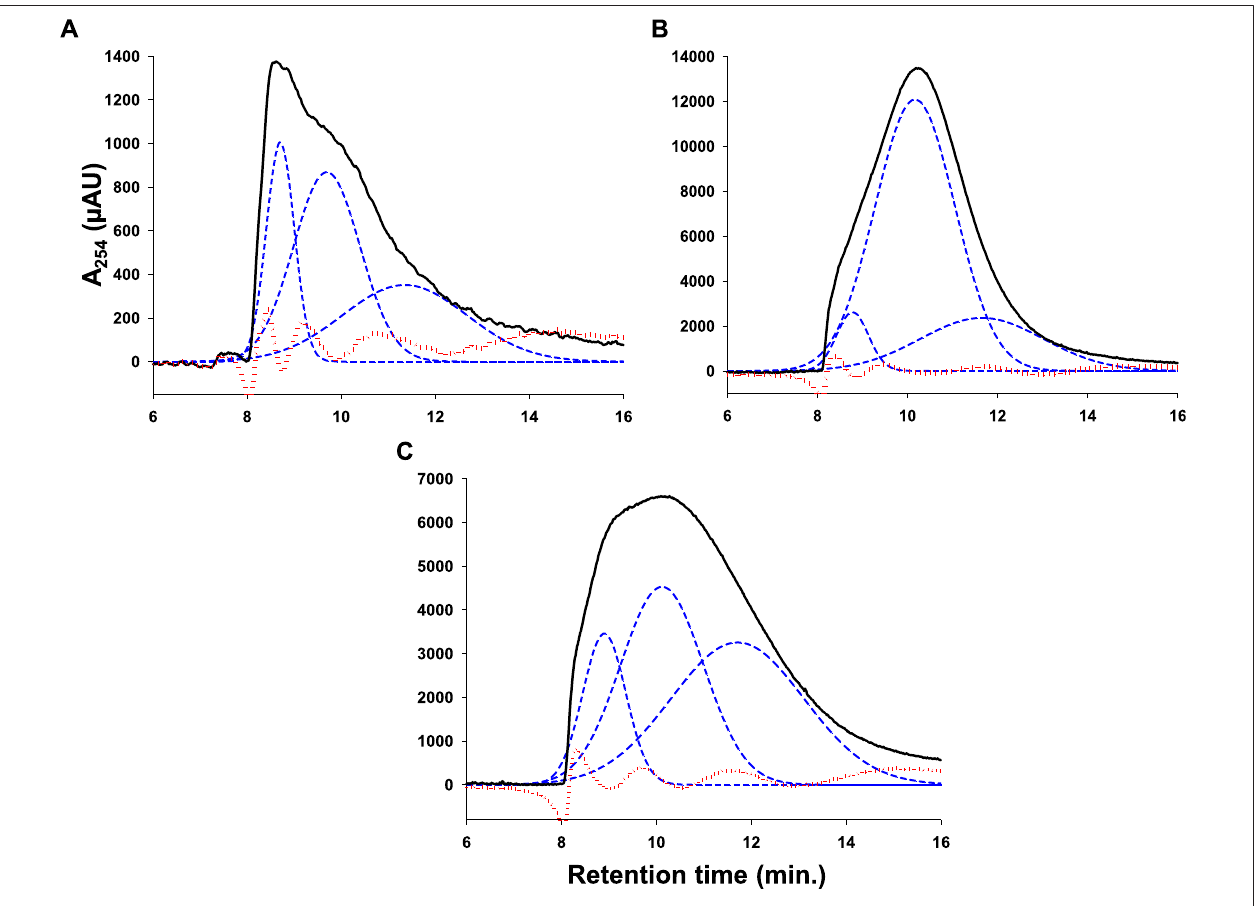
FIGURE2| Fractograms ( ─ ),deconvolutedpeaks ( --- ),and modelresiduals( ··· )for (A) balsam(BL1), (B) Otonabee river(OR1),and (C) willow(WL)endmembers.